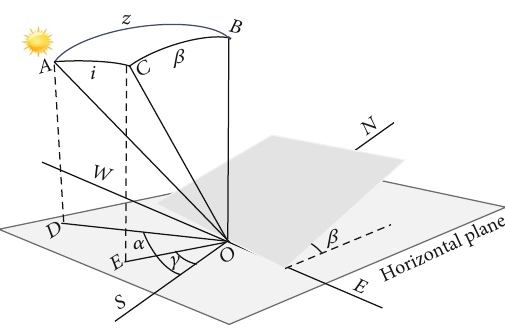
Figure 2: Solar radiation on tilt photovoltaic